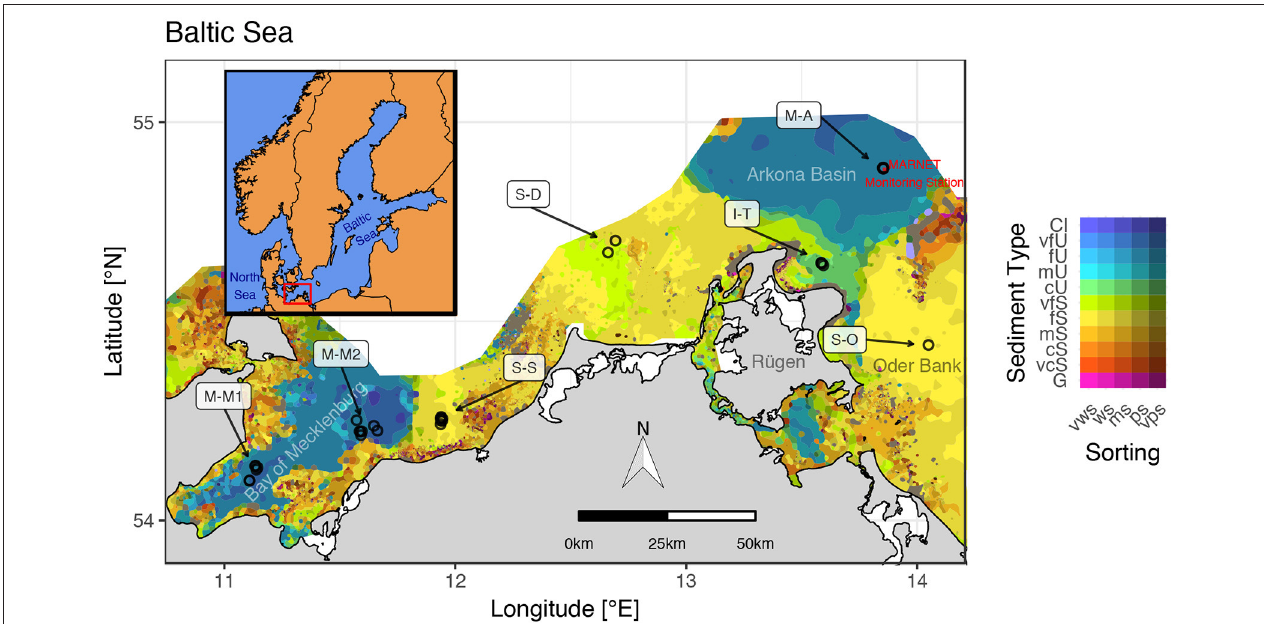
FIGURE 1 | Sampled sites and sediment type distribution in the southern Baltic Sea. Sediment distribution map is redrawn from Tauber (2014). Abbreviations in the legend follow the Wentworth classes: Cl, clay; U, silt; S, sand; G, gravel with graduations of very fine (vf), fine (f), medium (m), and coarse (c). Sediment sorting classes range from very well sorted (vws) over moderately sorted (ms) to very poorly sorted (vps). The red area in the Arkona Basin marks the 500 m exclusion zone around a BSH MARNET monitoring station.